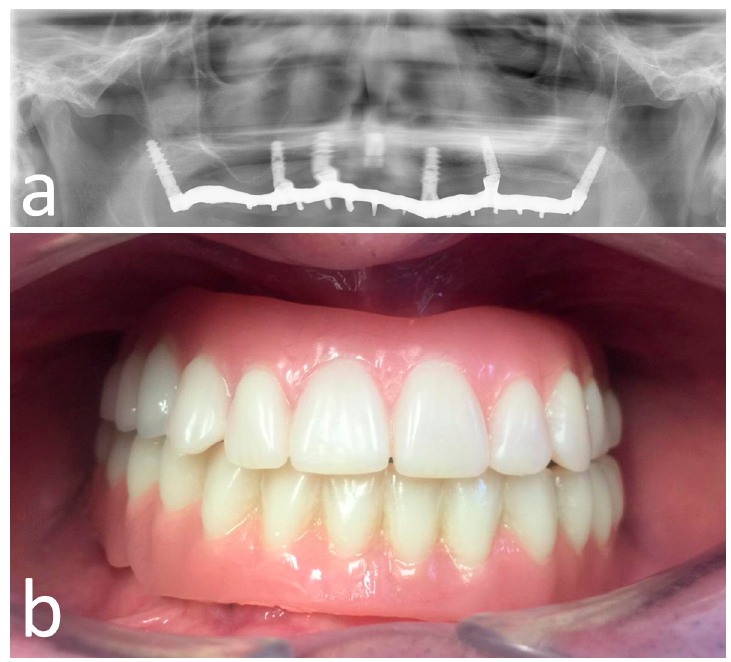
Figure 7. Opt X-ray ( a ) and clinical ( b ) view of the provisional prosthesis realized using conventional straight and angled multi-unit abutment (M.U.A.).